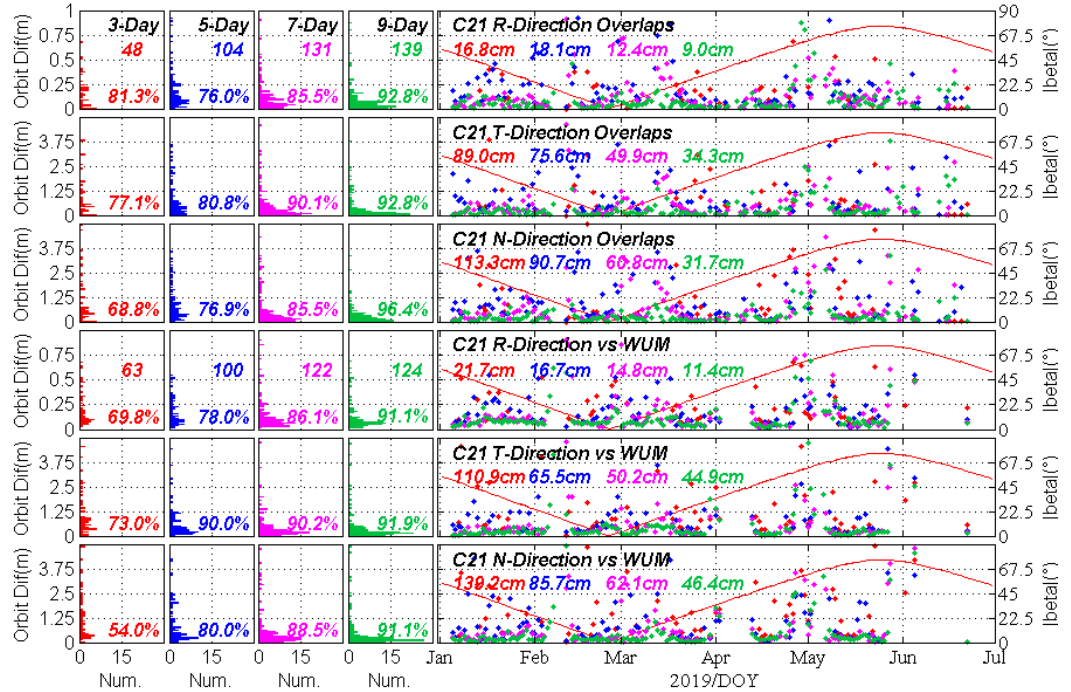
Figure 12. The results of SLR-only orbit determination for C21.